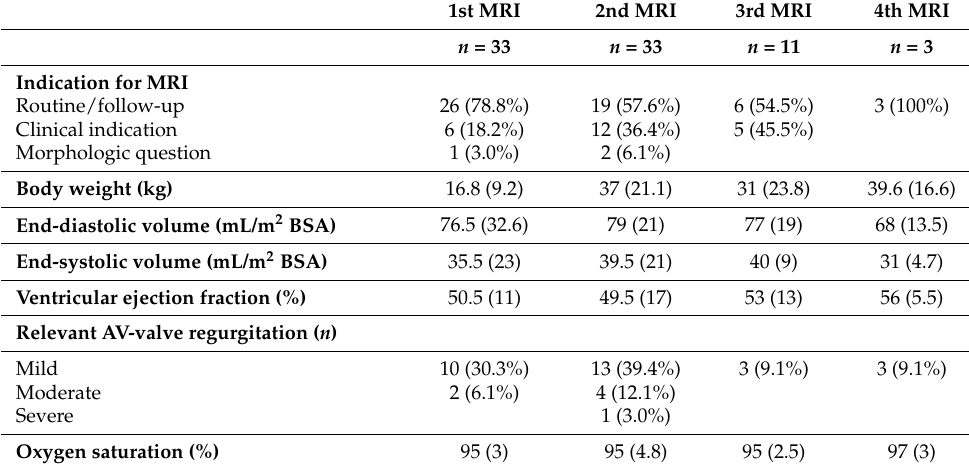
Table 4. MRI parameters and lymphatic abnormalities.